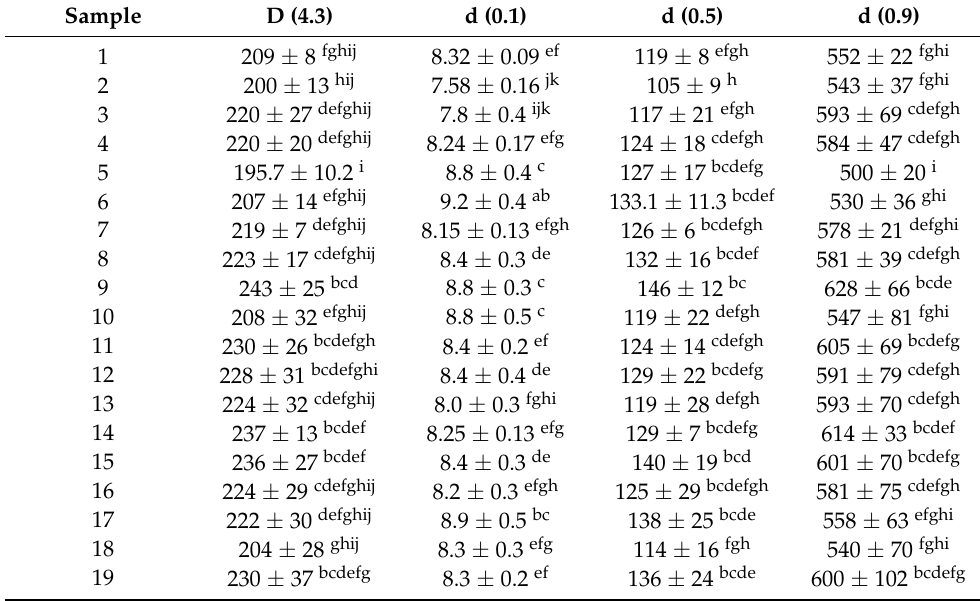
Table 2. Mean values ± standard deviation of the volumetric mean diameter ( µ m) D [4.3] and the standard percentiles ( µ m) d (0.01), d (0.05) and d (0.09) of each of the samples obtained. Superscript letters within columns indicate homogeneous groups according to ANOVA ( p < 0.05).